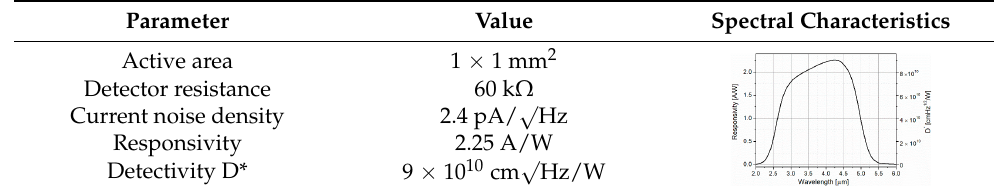
Table 4. Parameters of the detection module.